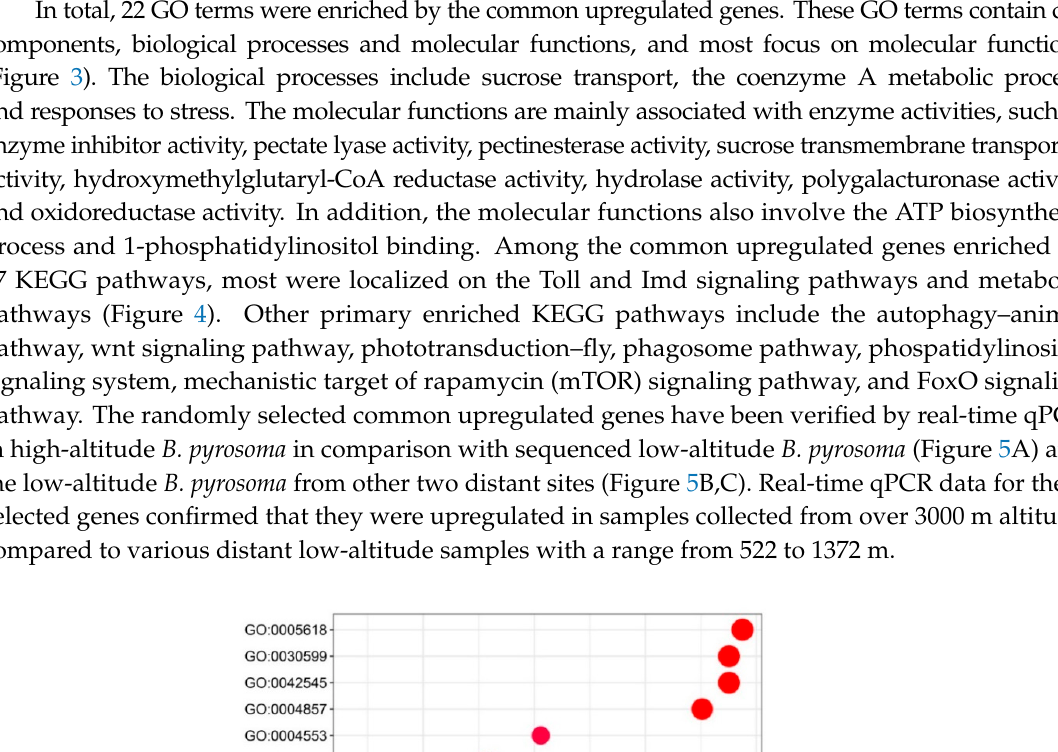
with nicotinamide adenine dinucleotide (NAD) or nicotinamide adenine dinucleotide phosphate (NADP) as the